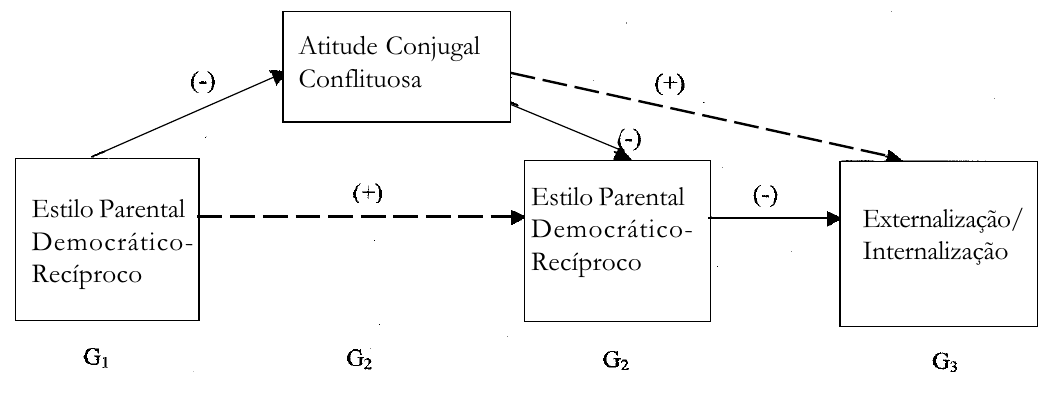
Figura 2. Modelo longitudinal mediativo de